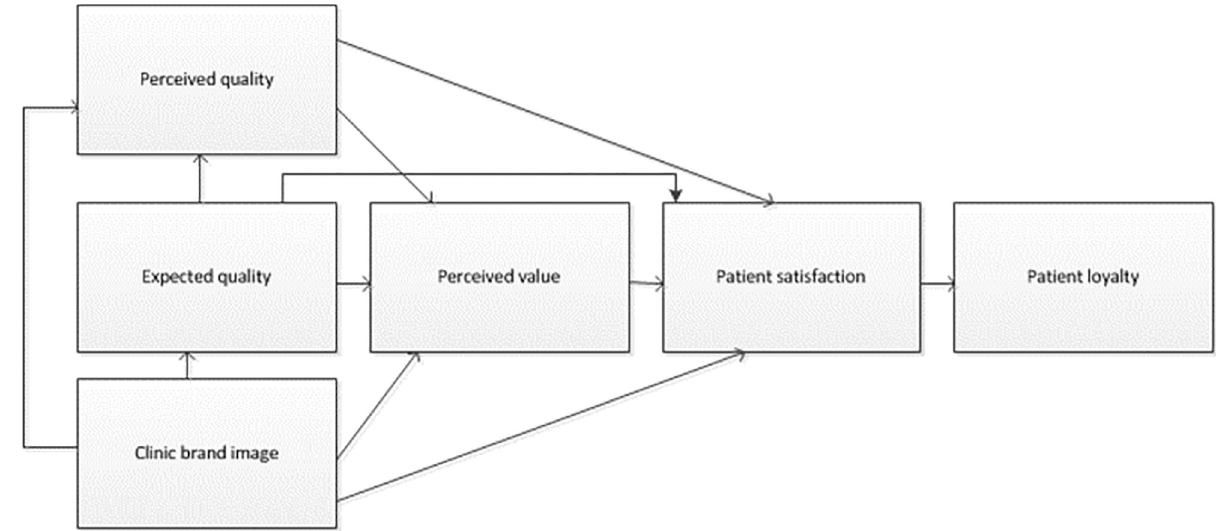
Fig 1. Theoretical framework. H1: Patient satisfaction has a positive influence on patient loyalty.